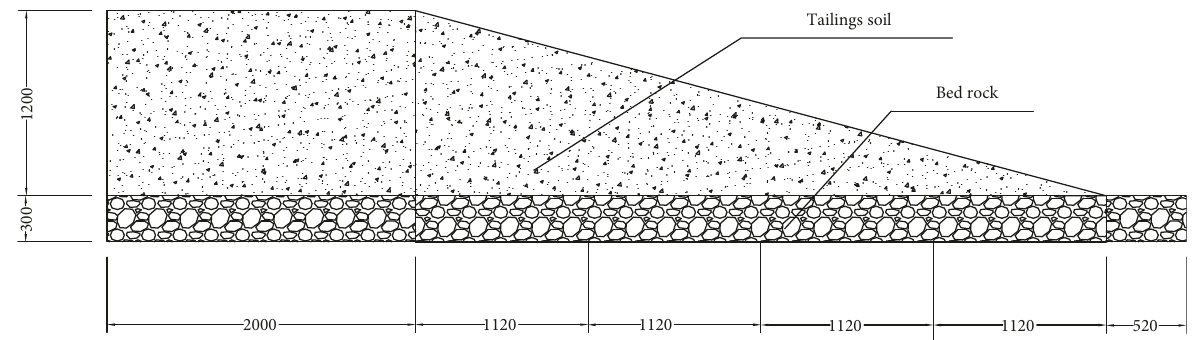
Figure 4: Schematic diagram of model filling (distance measured in